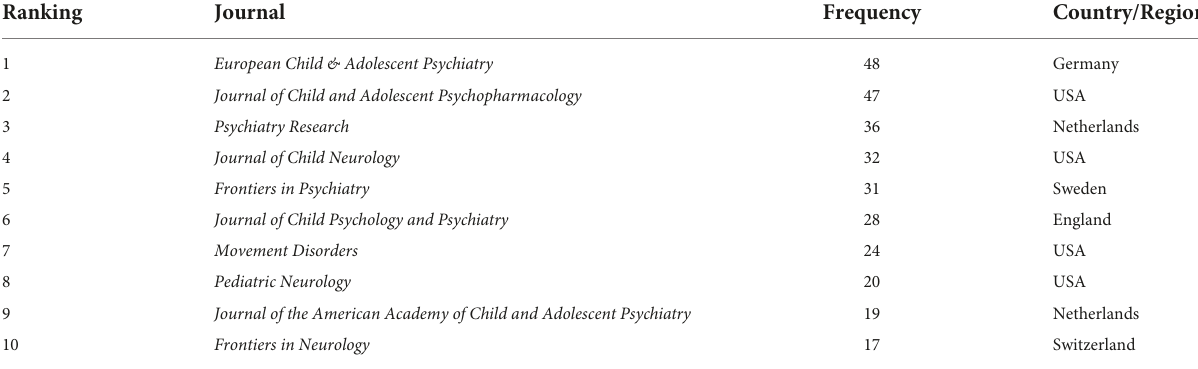
TABLE 5 The top 10 co-cited journals with the highest frequency related to Tourette Syndrome (TS) in children research from 2011 to 2021.